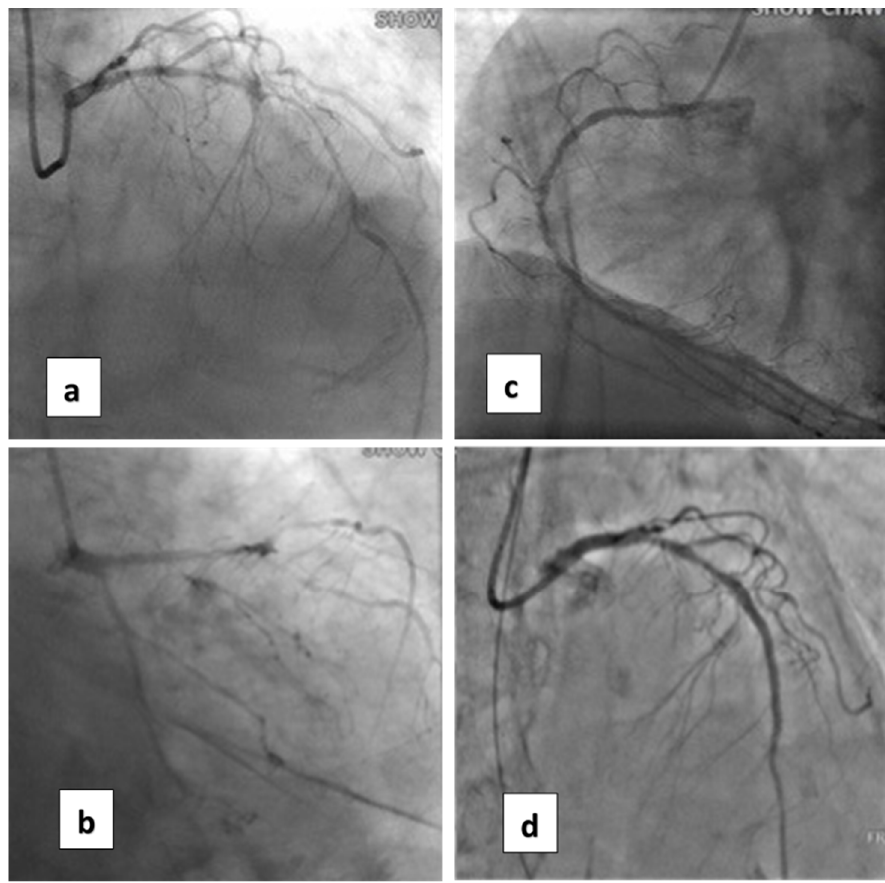
Figure 1. Coronary artery lesions of the patient. ( a ) Cranial view of coronary angiogram (CAG) revealed diffuse severe stenosis of the left anterior descending artery (LAD). ( b ) Caudal view of CAG shows total occlusion of the left circumflex artery (LCX). ( c ) CAG of the right coronary artery (RCA). ( d ) After percutaneous angioplasty (PCI) with two stents for LAD.